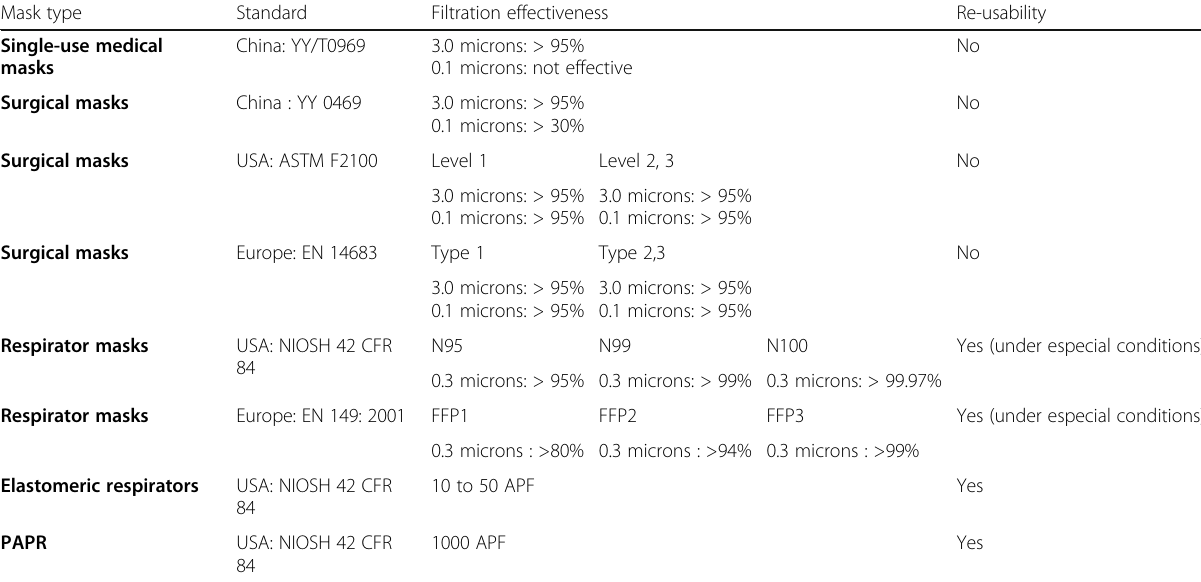
Table 2 A brief comparison between masks and